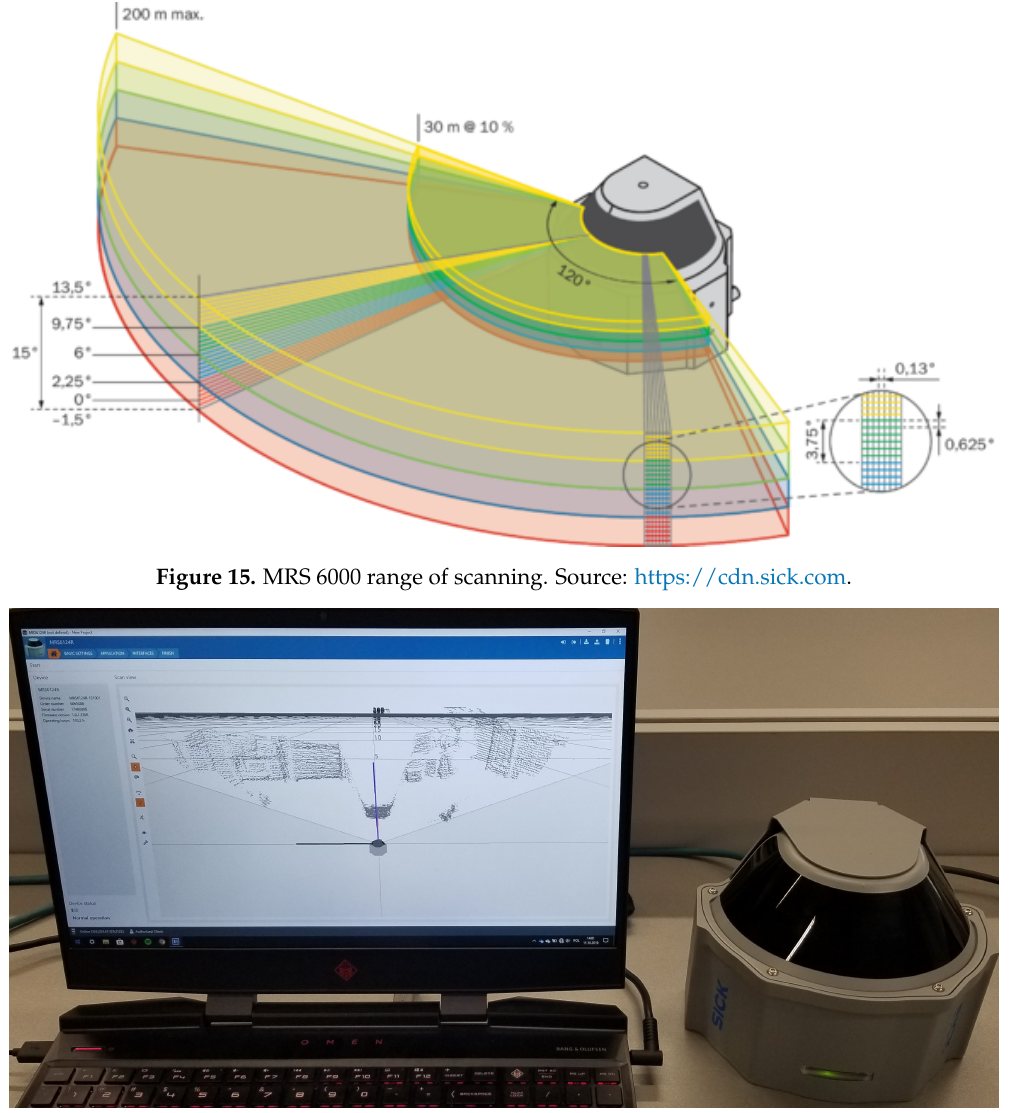
Figure 16. MRS 6124R testing with SOPAS ET